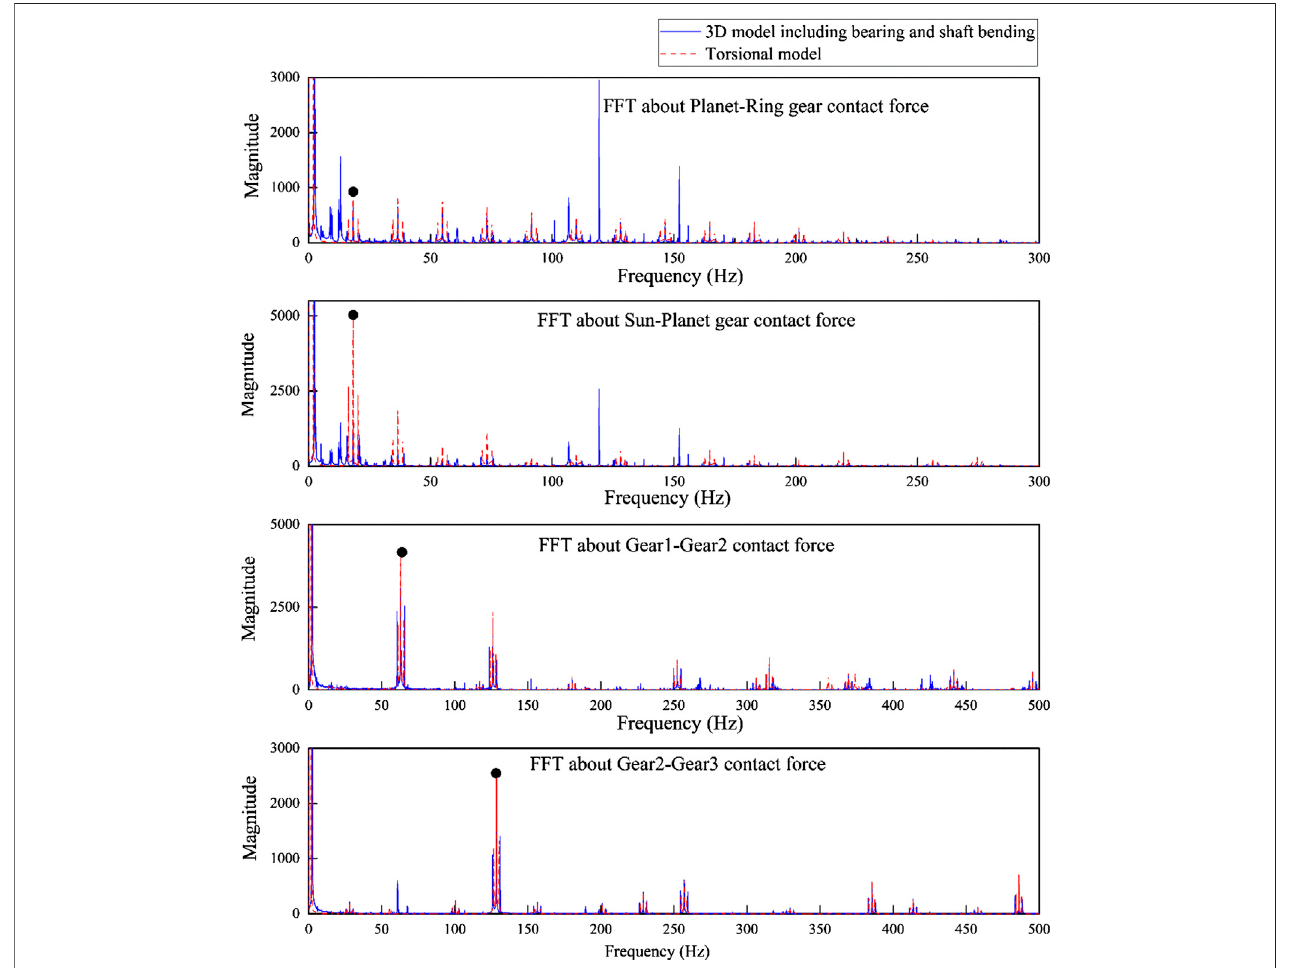
FIGURE 8 | FFT of the gear mesh contact